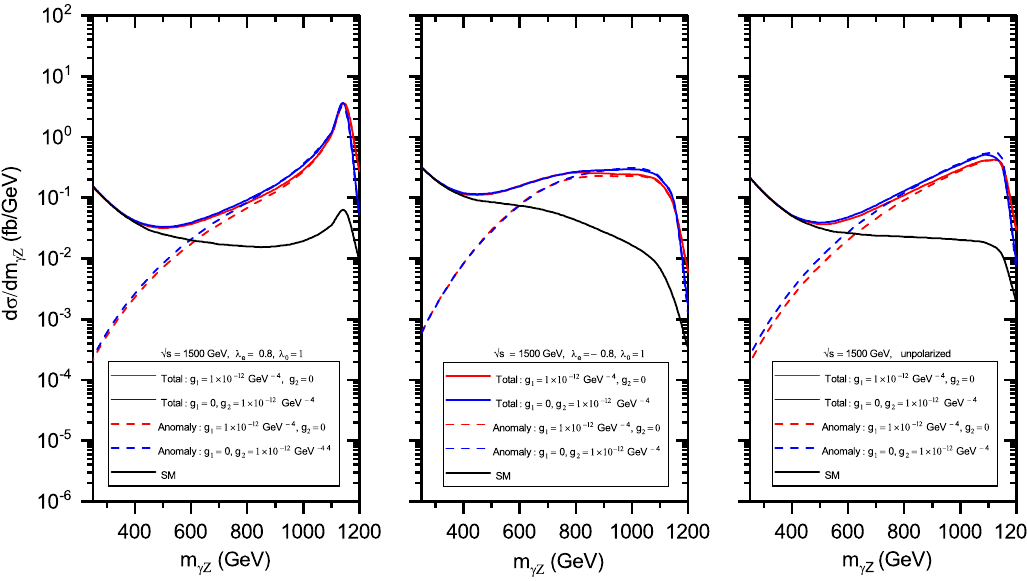
Figure 2 . The differential cross sections for the process γγ → γZ as functions of the invariant √ mass of the outgoing bosons for the CLIC energy s = 1500 GeV. The left, middle and right panels correspond to the electron beam helicities λ e = 0 . 8 , − 0 . 8 , and 0, respectively. On each plot the curves denote (from the top downwards) the differential cross sections for the couplings g 1 = 10 − 12 GeV − 4 , g 2 = 0 , and g 1 = 0 , g 2 = 10 − 12 GeV − 4 , the anomalous contributions for the same values of couplings, the SM cross section.